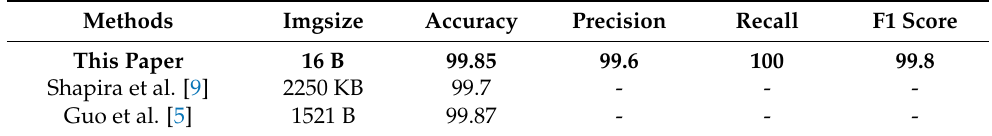
Table 7. Performance comparison of VPN traffic detection